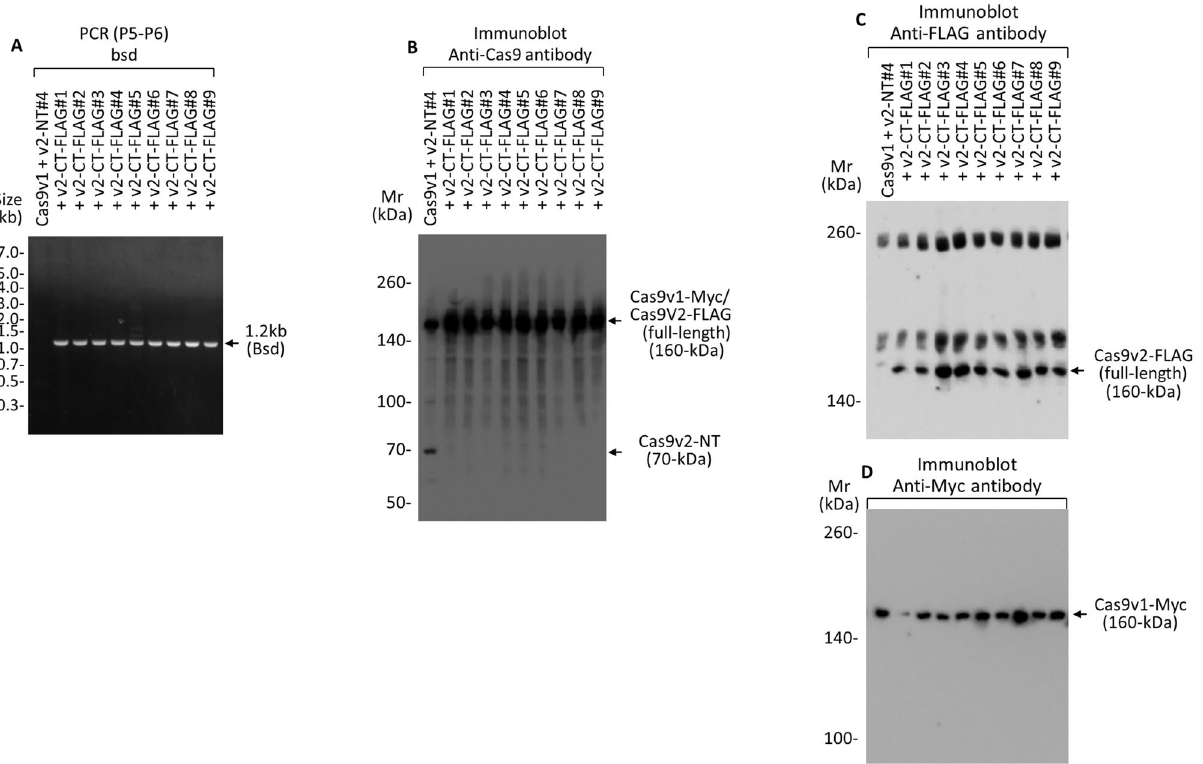
Figure 5. PCR and immunoblot to confirm the reconstitution of full-length Cas9v2-FLAG in AAVS1 locus. ( A ) PCR analysis of genomic DNA prepared from the HEK293T-Cas9v1-Myc + Cas9v2-NT #4 cells and the HEK293T-Cas9v1-Myc cells expressing full-length Cas9v2-FLAG (+ v2-CT-FLAG #1–#9), after AAV vector #2 infection and blasticidin selection. The DNA was amplified by primers P5–P6 and the 1.2 kb PCR products indicating the integration of donor elements (Bsd gene) were detected in all clones. ( B – D ) Lysates obtained from the cells used in ( A ) were analyzed by immunoblot with an antibody against Cas9 that recognizes both Cas9s, after 6% SDS-PAGE. The 70-kDa band indicates the 1.9 kb N-terminal Cas9v2 ( B ). The 160-kDa band was confirmed with the specific tag antibodies to contain the reconstituted full-length Cas9v2-FLAG ( C ) and Cas9v1-Myc ( D